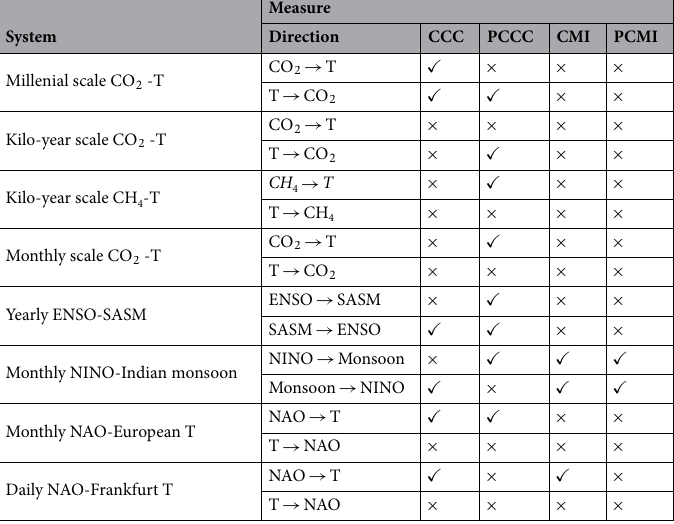
Table 1. Causal inference obtained for real datasets using different causality measures. (cid:31) indicates significant causality and × indicates non-significant